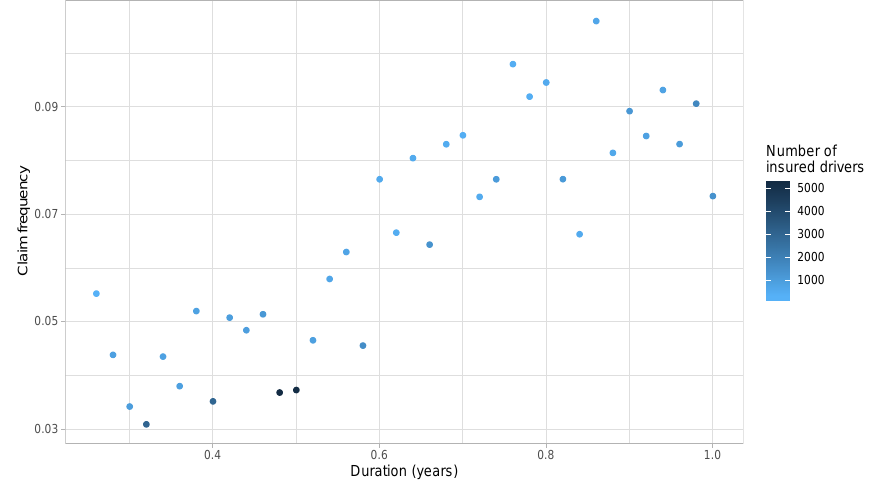
Figure 5. Claims Frequency vs. Exposure Time.